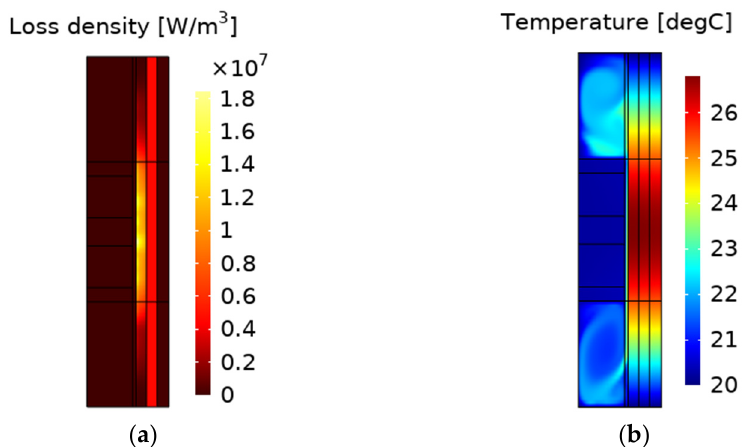
Figure 12. ( a ) Cycle-averaged volumetric electromagnetic power losses and ( b ) the steady-state temperature field at 15